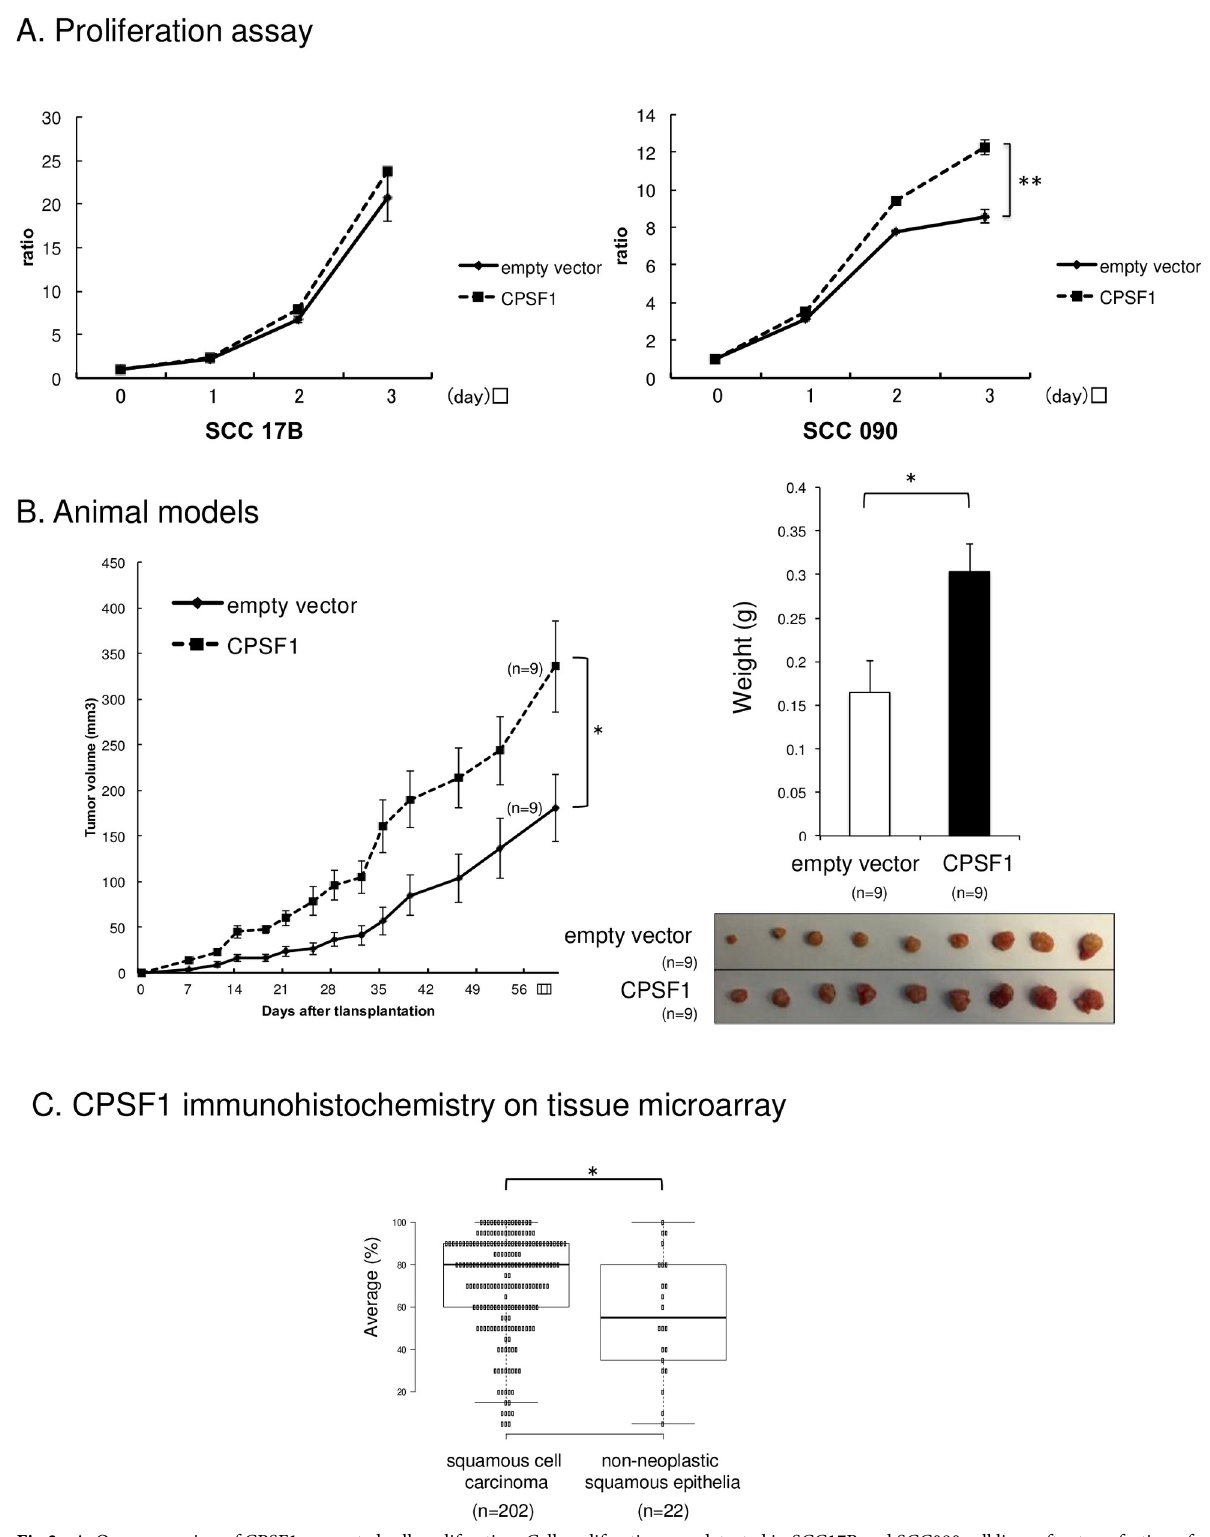
Fig 3. A. Overexpression of CPSF1 promoted cell proliferation. Cell proliferation was detected in SCC17B and SCC090 cell lines after transfection of empty vector and CPSF1 vector. The proliferation of the SCC090 cells overexpressing CPSF1 was significantly increased compared to empty